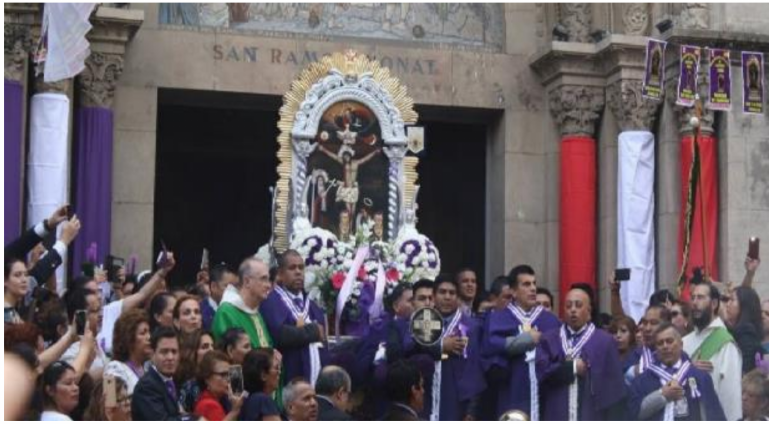
Figure 1. Brotherhood of the Lord of Miracles singing the Peruvian National Anthem, October